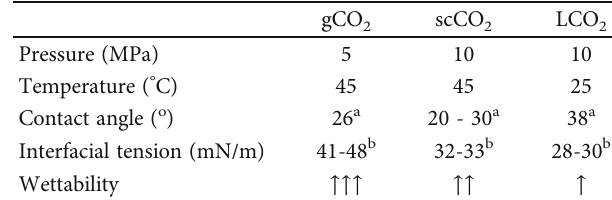
) is de fi ned as the di ff erence between c is the saturation of mercury. Hg conditions used in this 2